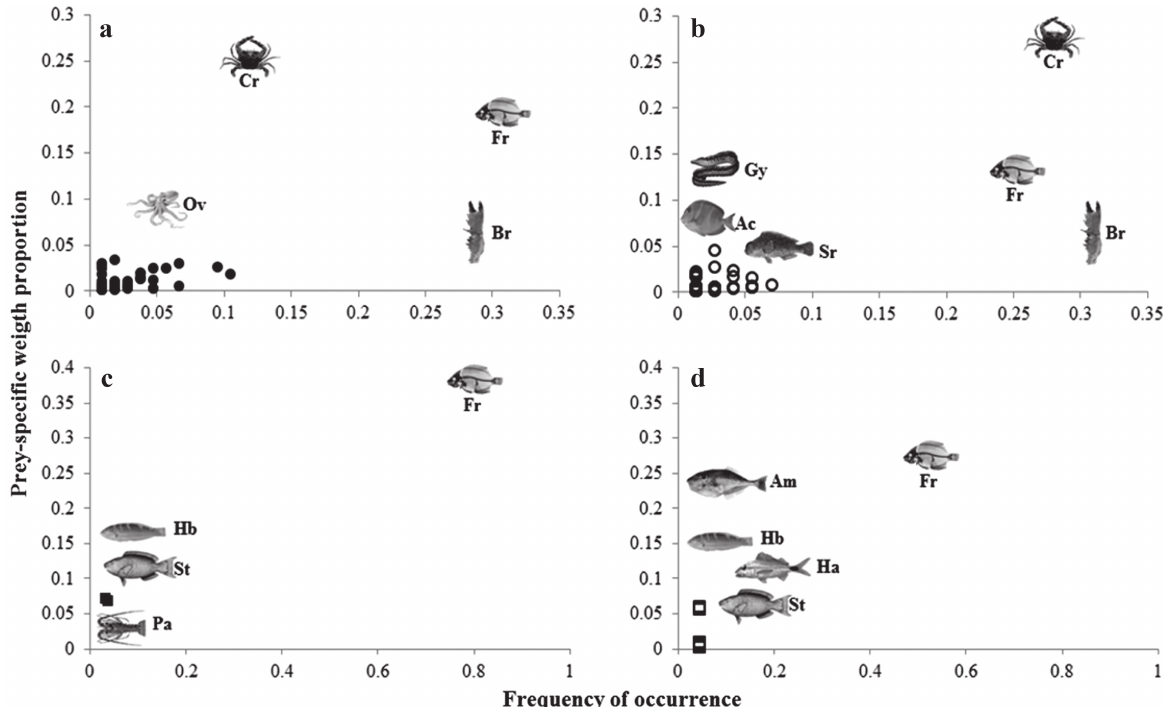
Fig. 2. Feeding strategy diagram incorporating the preys taxa of red ( a, b ) and black ( c, d ) groupers and their feeding strategy classification in the Abrolhos Bank for juveniles ( a, c ) and adults ( b, d ). Images of select items are offset to the right of symbols for visual interpretation. Abbreviations: Cr= Cronius ruber ; Fr= Fishes remains; Br= Brachyura remains; Gy= Gymnotorax spp.; Ac= Acanthurus spp.; Ov= Octopus vulgaris ; St= Scarus trispinosus ; Sr= Scaridae remains; Pa= Panurilus argus ; Hb= Halichoeres brasiliensis ; Ha= Haemulon aurolineatum ; Am= Aluterus monocerus